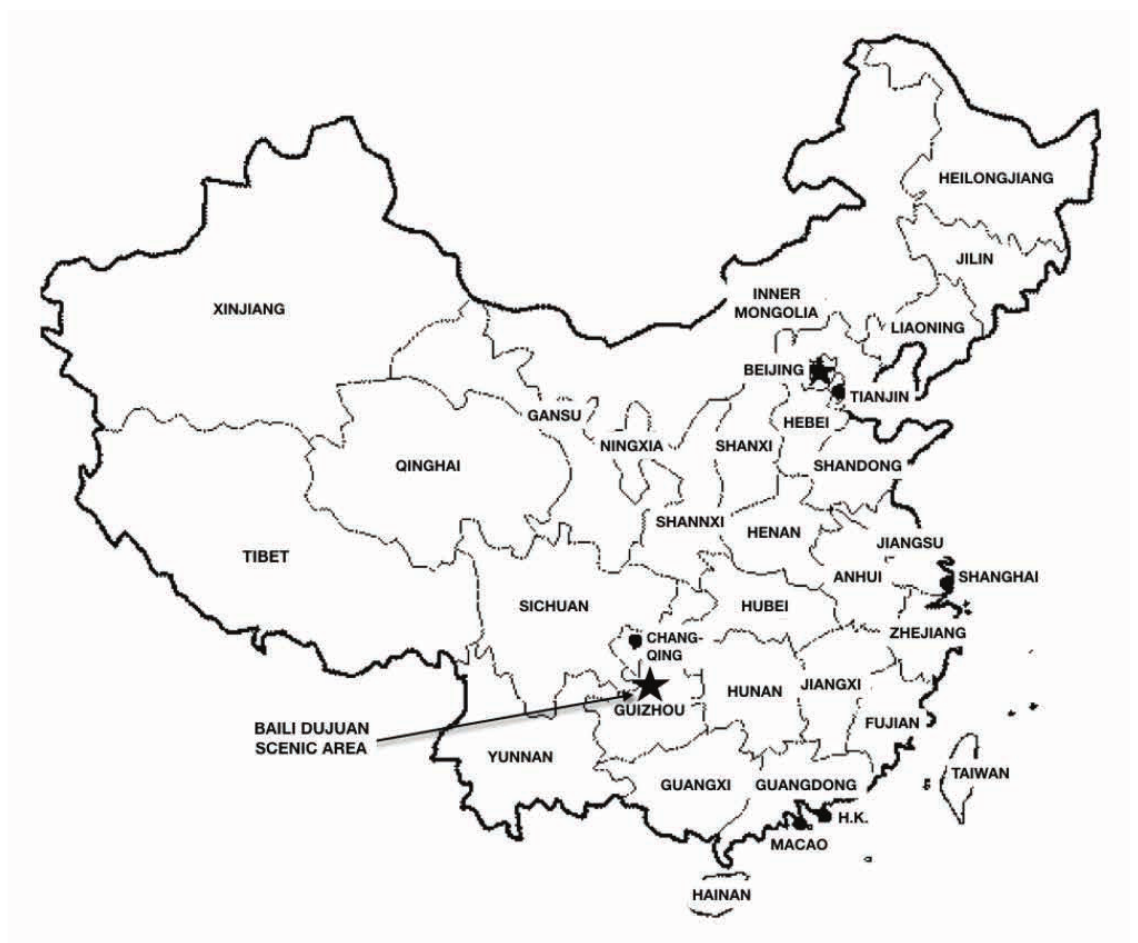
Figure 4: Location of Baili Dujuan Scenic Area in